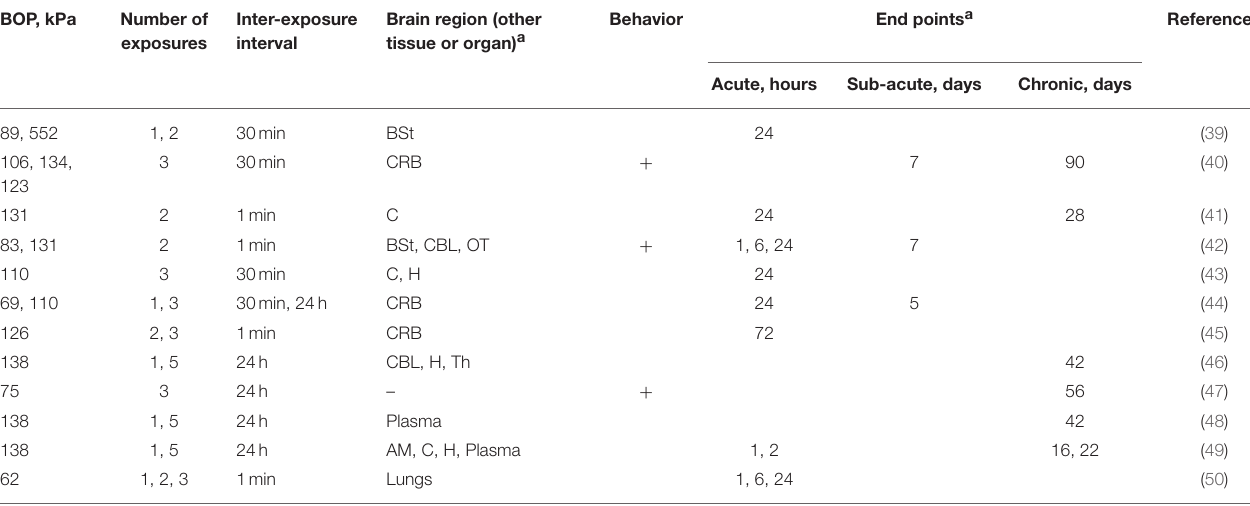
TABLE 2 | The summary of experimental variables (exposure conditions: BOP, number of exposures and inter-exposure interval, analyzed brain region, behavioral testing and end points) in studies using Sprague Dawley rats. BOP,